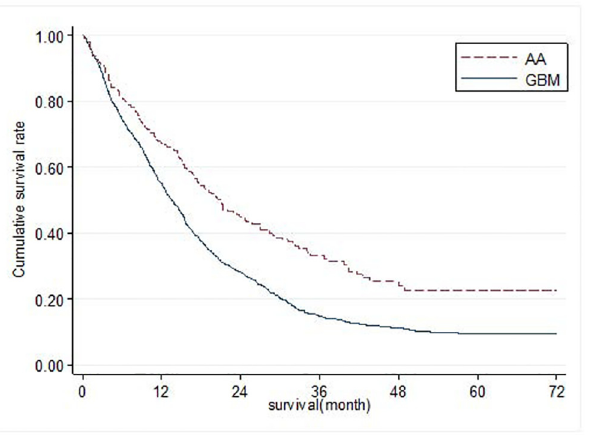
Fig 2. Overall Survival of Patients with Anaplastic Astroctyoma (AA) or Glioblastoma (GBM) in